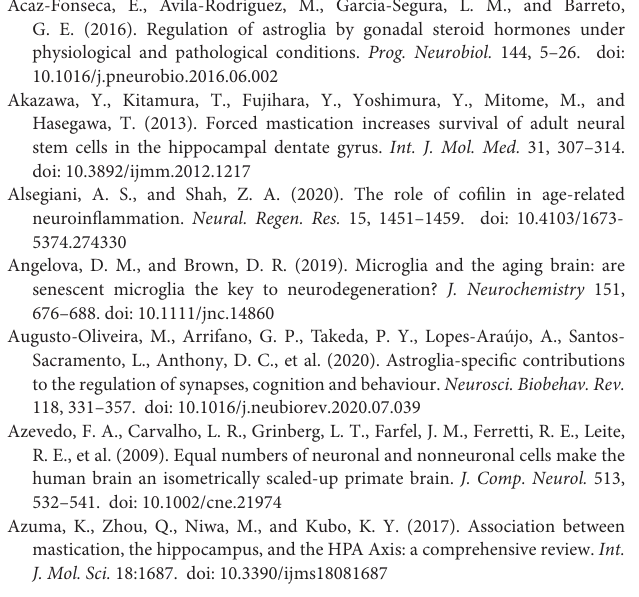
Supplementary Table 8 | Representation of values obtained after Analysis of Variance (ANOVA) – three way with Tukey post-test ( q ) and p -value ( p ) significant for the mean swimming velocity (cm/s) at the 4th testing day in the different groups by regime, age and environment.